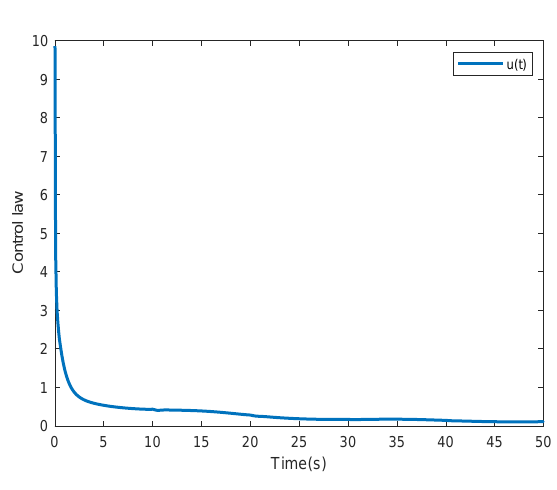
Figure 4. Sliding surface function s ( t ) .